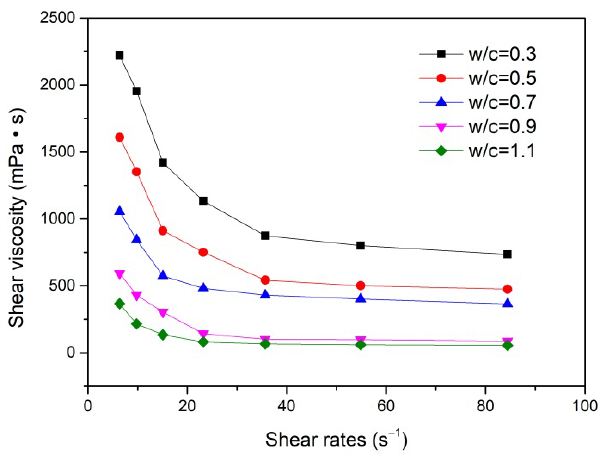
Figure 1. Rheological behavior of the cement paste with different water/cement ratios.